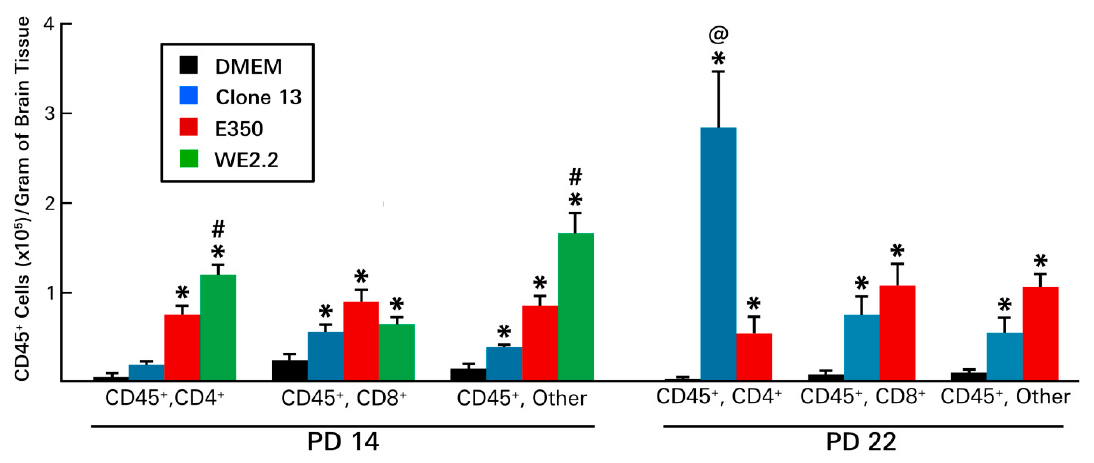
Figure 8. The different strains of LCMV induced different patterns of infiltrating immune cells. At PD14 (left panel): All three viral strains provoked infiltration of hemopietic cells. However, the infiltrations induced by the E350 and WE2.2 strains were much greater than that induced by the Clone 13 strain. In addition, among the strains, the identities of the infiltrating cells differed. For the E350 strain, CD8+ cells represented the plurality, while for the WE2.2 strain, only a small proportion were CD8+ and most were neither CD4+ nor CD8+. By PD22 (right panel), substantial changes in the profiles of infiltrating cells emerged. By this time point, Clone 13 had induced a large increase in the infiltration of CD4+ cells, a development not observed in the animals infected with E350. * = significantly different from DMEM control (p<0.05); #=significantly different from all other groups ( p < 0.05); @ = significantly different from all other groups ( p < 0.01). Error bars represent standard error of the mean.